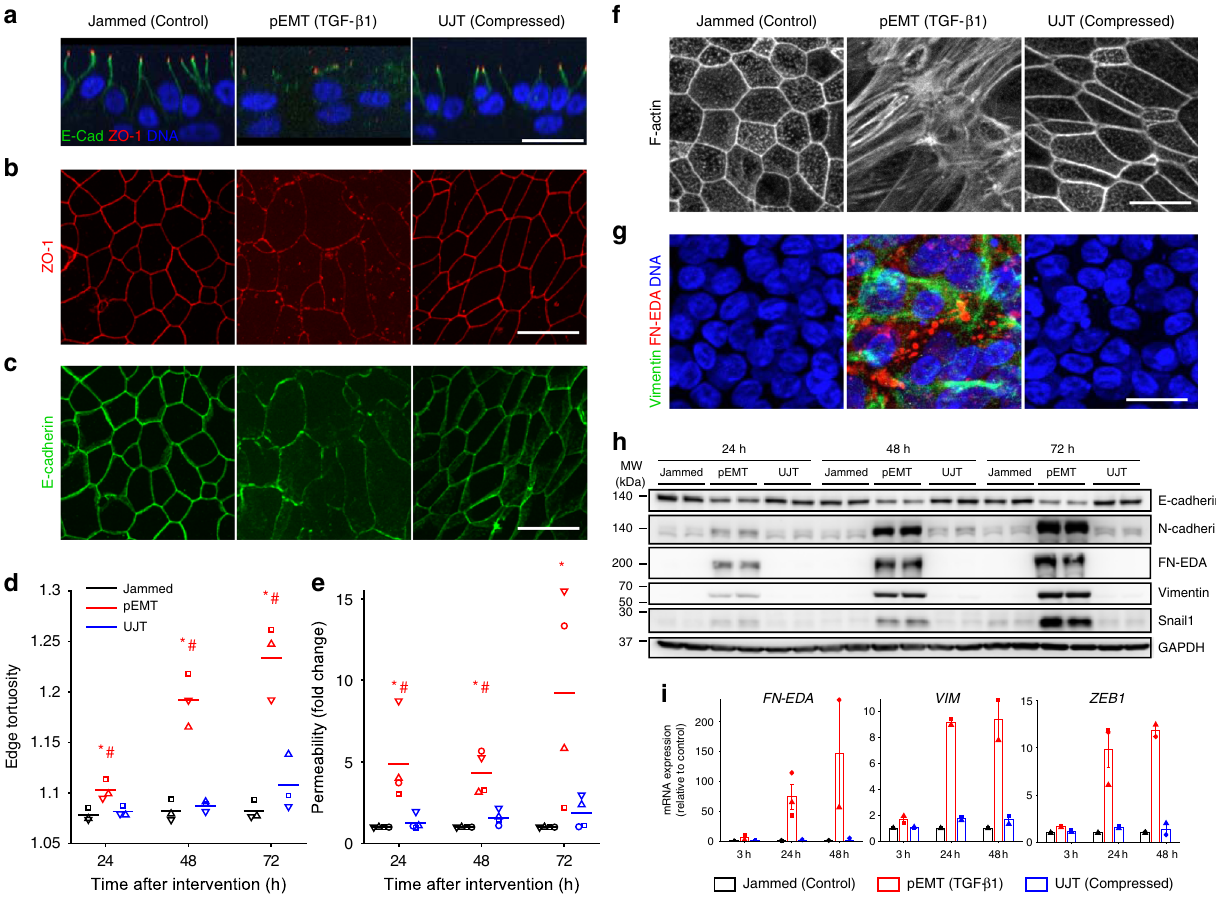
Fig. 2 UJT occurs without evidence of pEMT. Representative immuno fl uorescence (IF) images ( a – c , f , g ) at 48 h after stimulus for jammed (control), pEMT (TGF- β 1-treated), and UJT (compressed) layers. Scale bars in all images are 20 µ m. See also Supplementary Figs. 1 and 2. a In both jammed and UJT layers, ZO-1 (red) localizes at apical tight junctions, while E-cadherin (green) localizes at lateral adherens junctions, consistent with the epithelial phenotype; DNA is shown in blue. In pEMT layers, both ZO-1 and E-cadherin delocalize from apical and lateral junctions, consistent with the mesenchymal phenotype. b , c In both jammed and UJT layers, apical tight junctions (ZO-1, b ) and lateral adherens junctions (E-cadherin, c ) remain intact, while in pEMT layers the cell edges comprised of these junctions become disrupted. d During UJT, cells elongate while maintaining straight cell edges, while during pEMT, cell – cell edges become progressively tortuous ( n = 3 donors, independent experiments). e Layer permeability measured by the dextran-FITC (40 kDa) fl ux assay signi fi cantly increases during pEMT but remains almost unchanged during UJT ( n = 4 donors, independent experiments). * p < 0.05, vs. control; # p < 0.05, pEMT vs. UJT, color-coded according to which sample is referenced, one-way ANOVA followed by post-hoc multiple comparisons test with Bonferroni correction d , e . f During pEMT, cortical actin becomes disrupted while apical stress fi bers emerge, indicating loss of epithelial character and gain of mesenchymal character. During UJT, cells maintain intact cortical F-actin; aside from elongated cell shape, cortical actin in jammed versus UJT is indistinguishable. g IF images stained for mesenchymal marker proteins: cellular fi bronectin (FN-EDA, red) and vimentin (green). FN-EDA and vimentin appear during pEMT but not UJT. Vimentin appears as basally located fi bers, while FN-EDA appears as cytoplasmic globules. h During pEMT, E-cadherin protein levels progressively decrease while mesenchymal markers, N-cadherin, FN-EDA, and vimentin, and the EMT-inducing transcription factor (TF) Snail1, progressively increase. During UJT, these protein levels remained unchanged. Western blot quanti fi cation shown in Supplementary Figs. 2, 3, and uncropped versions of the blots are available in the accompanying online Source Data fi le. i During pEMT, mRNA expression of mesenchymal markers, shown as fold-change relative control, VIM and FN-EDA and the EMT-inducing TF ZEB1 , are signi fi cantly elevated, but during UJT remain unchanged. Shown: mean ± SEM for n = 3 donors with overlaid data points showing fold-change for each